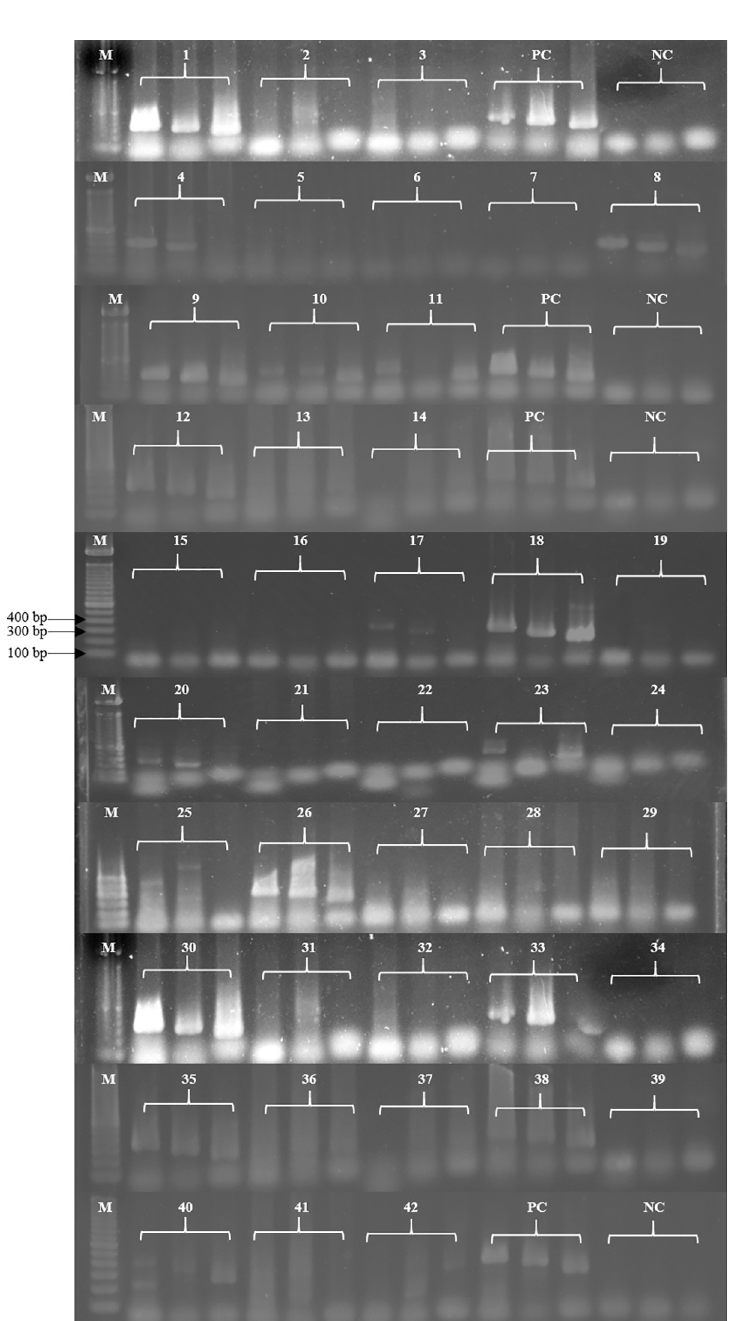
Fig 1. Diamond ™ nucleic acid dye stained agarose gel image of PCR amplified products of 5.8S rRNA, 18S rRNA, and repetitive DNA regions for all three primers TFR1/2, TV16Sf/r, and TVK3/7. M: 100 bp molecular marker; PC: positive control; NC: negative control. Among the samples, sample number 1, 8, 9, 10, 12, 18, 26, 30, 35, 38, and 40 showed positivity for all three primer sets TFR1/2, TV16Sf/r, and TVK3/7; sample number 4, 7, 20, and 33 showed positivity only for TFR1/2 and TV16Sf/r; and sample number 11 and 23 showed positivity only for TFR1/2 and TVK3/7.